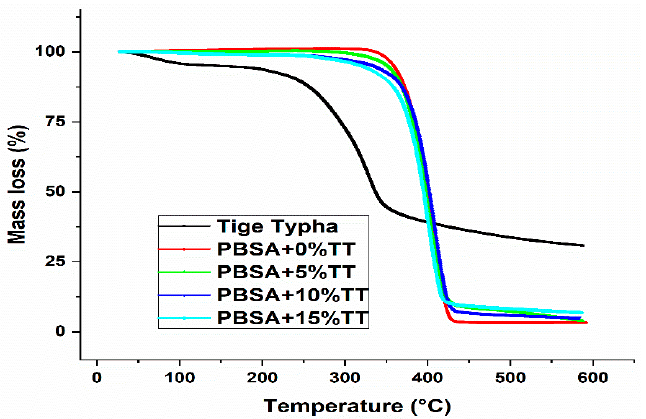
Figure 5. Thermogravimetry (TGA) of virgin PBS and its biocomposites.